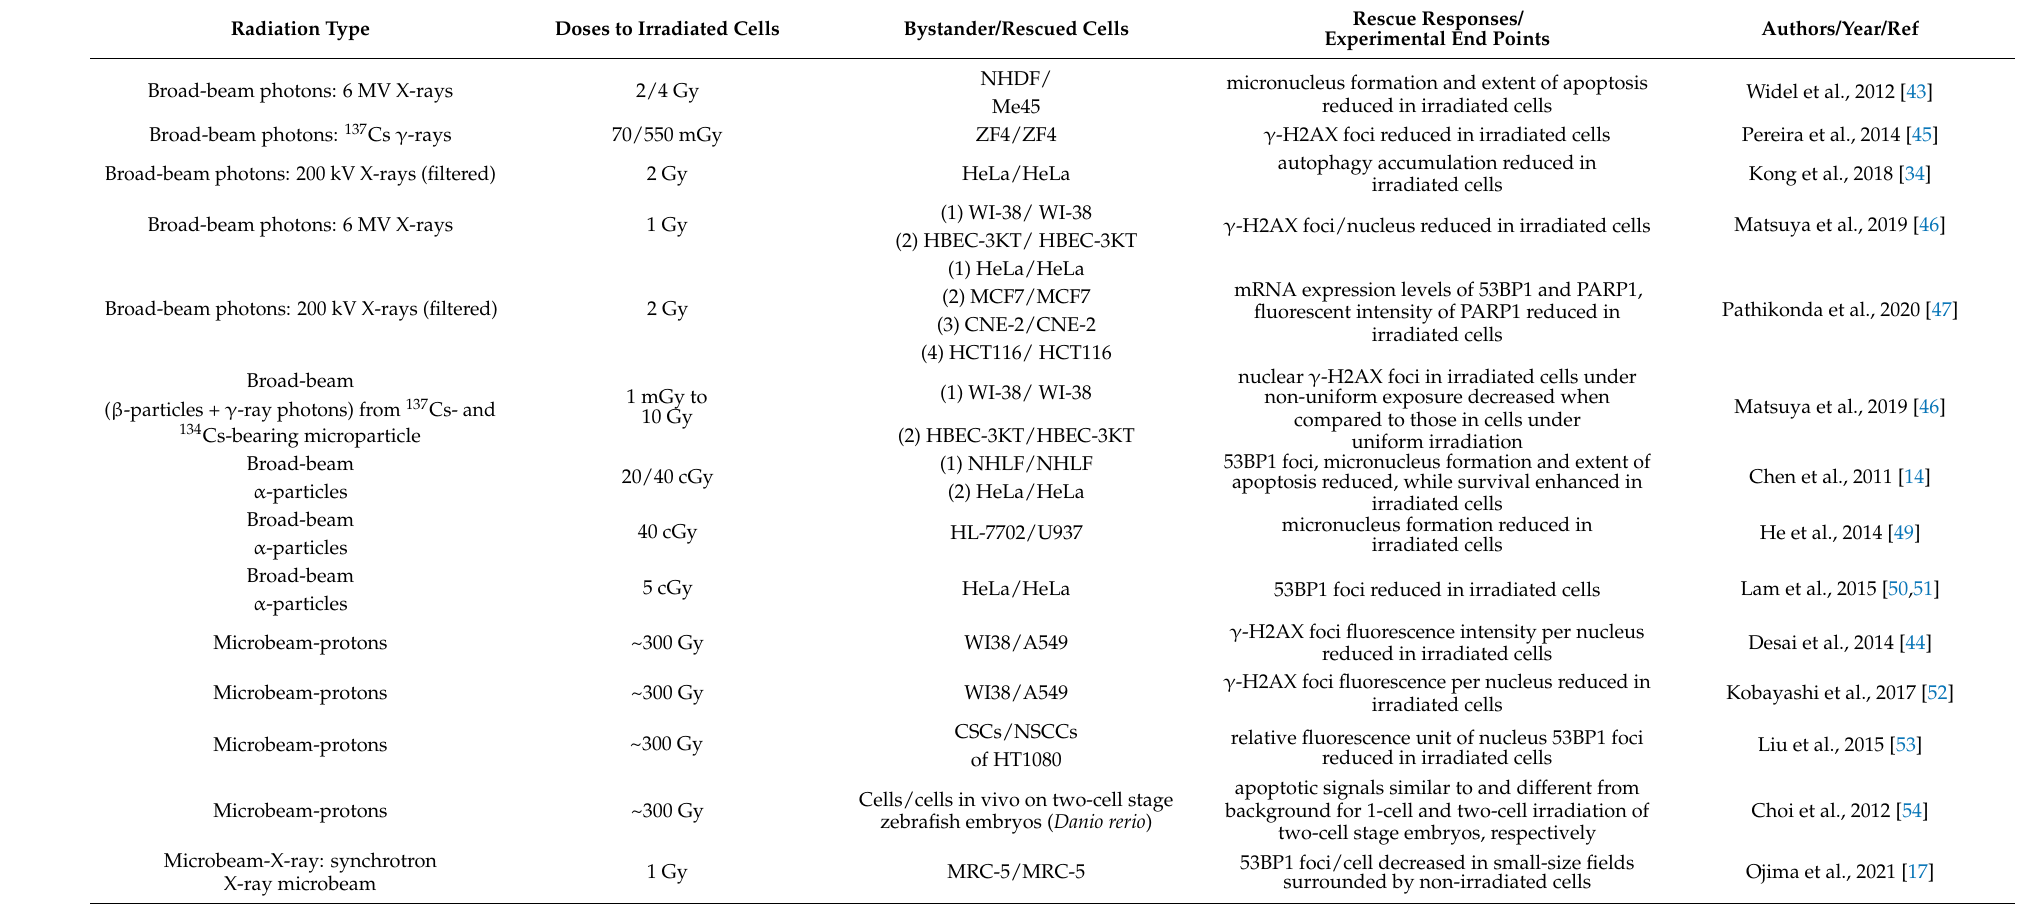
Table 1. Summary of studies by various research groups who demonstrated RIRE through different types of ionizing radiations, doses, combination of by- stander/rescued cells, experimental end points and rescue